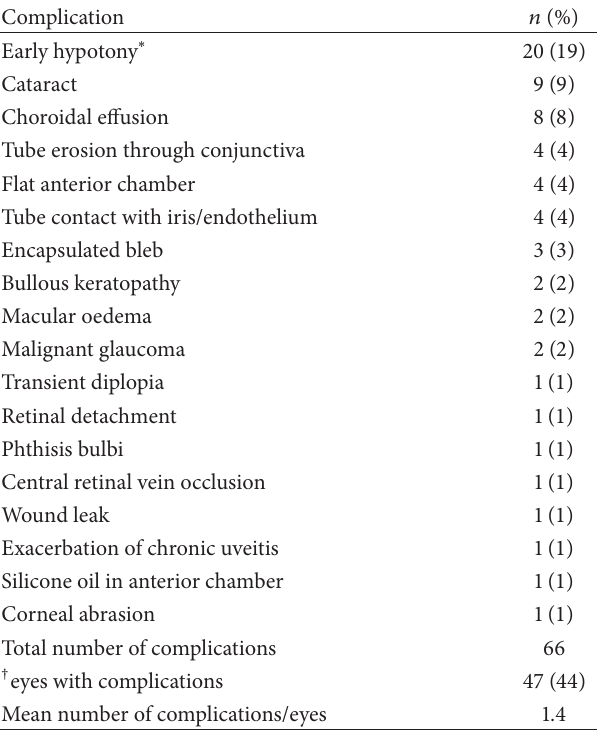
Table 3: All postoperative complications in 106 eyes of 97 patients.